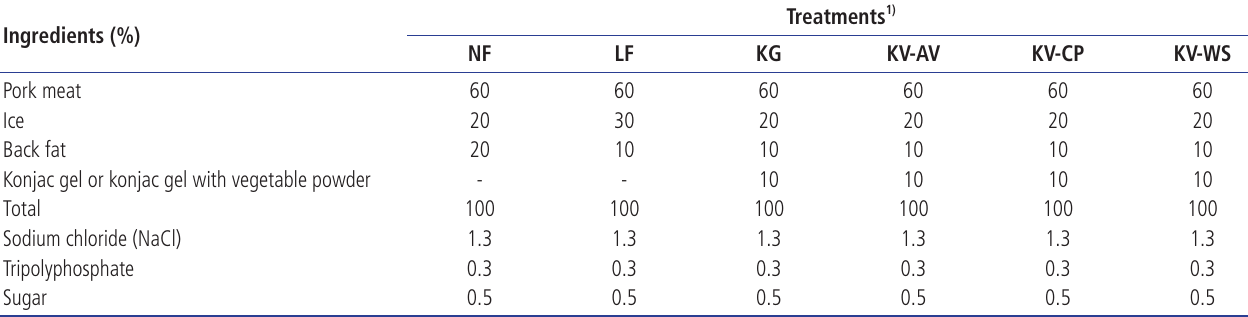
Table 1. Formulations of frankfurter sausages Ingredients